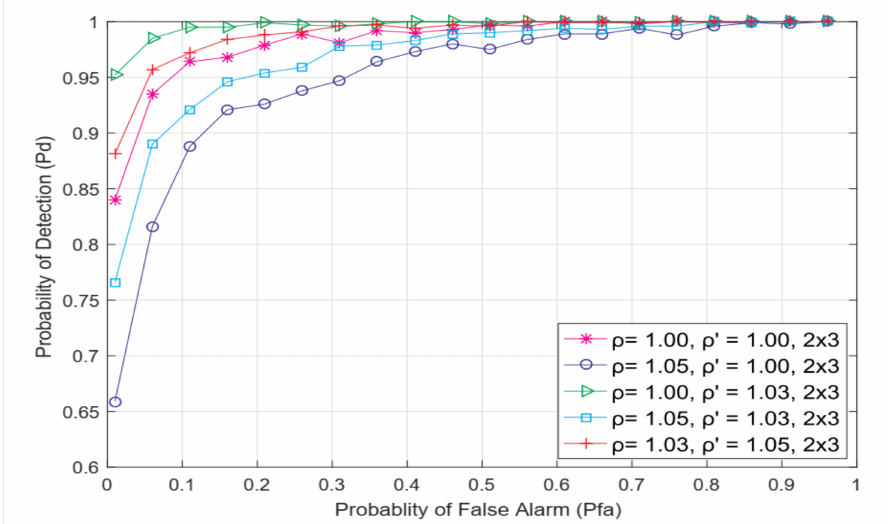
Figure 5. The ROC curves for various NU and DDT factor combinations in asymmetric 2 × 3 MIMO systems characterized by transmission with m-PSK/m-QAM modulation, N = 128, SNR = − 15 dB and P Tx = 100